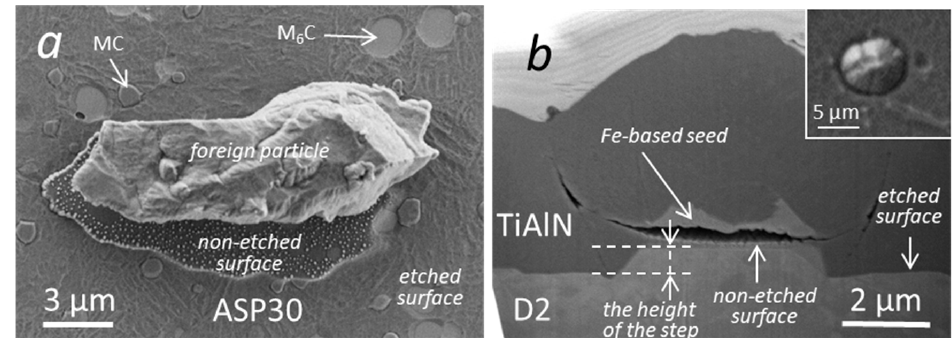
Figure 7. A foreign particle which remains on the substrate surface after the wet cleaning procedure, prevents etching of the substrate area underneath it ( a ); a step on the substrate surface beneath the iron-based seed proves that the seed particle was on the substrate surface even before etching ( b